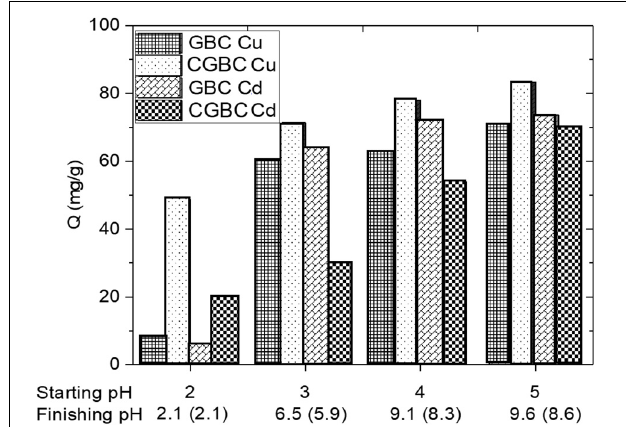
FIGURE 3 | Effect of pH on Cu 2 + and Cd 2 + ion adsorption onto GBC and CGBC using 0.025 g of adsorbent and 25 mL 100 ppm solutions of each metal ion at the desired pH. Both starting and finishing pH values for GBC (CGBC) are shown.